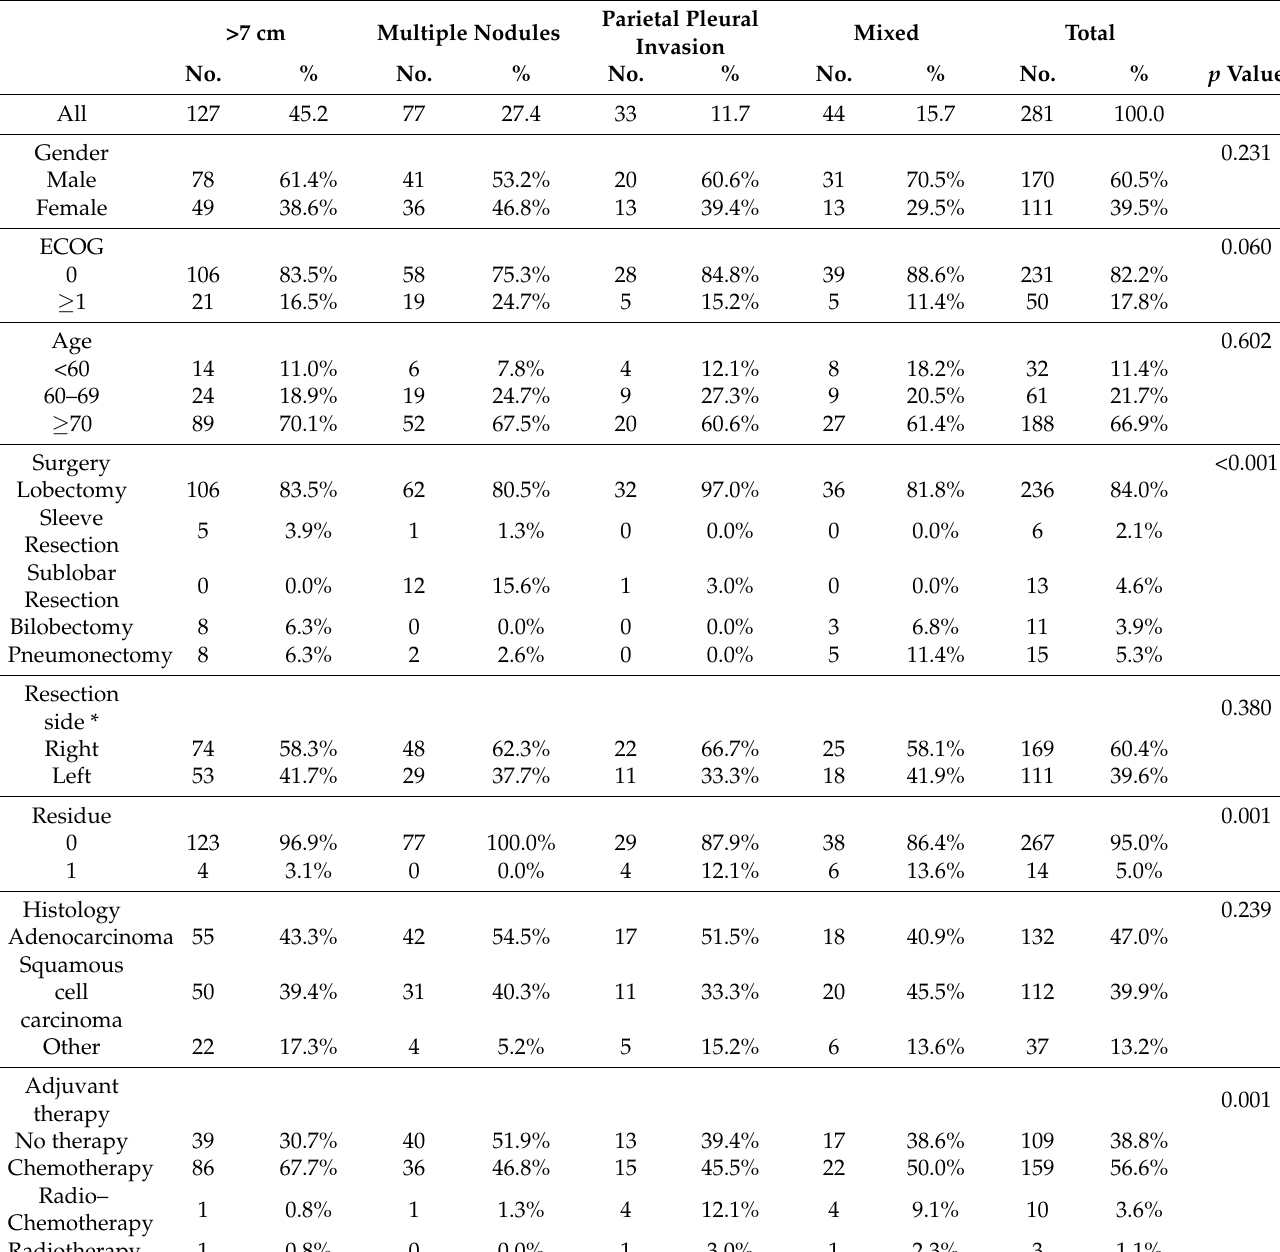
Table 2. Descriptive analysis of the characteristics of the four major pT3N0